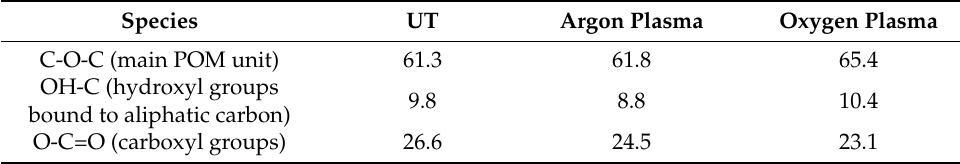
Table 3. XPS data O1s obtained for untreated and plasma-treated